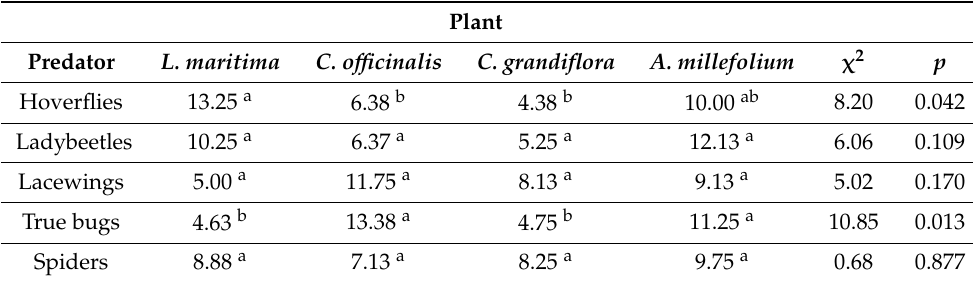
Figure 7. Proportion (%) of predatory groups recorded on service plants: sweet alyssum ( L. maritima ), marigold ( C. officinalis ), large-flowered tickseed ( C. grandiflora ), and yarrow ( A. millefolium ). Table 4. Mean rank, χ 2 and p of the Kruskall–Wallis test from the abundance comparison of predator groups between service plant species. For each predator, values followed by different letters show statistical differences between service plants.